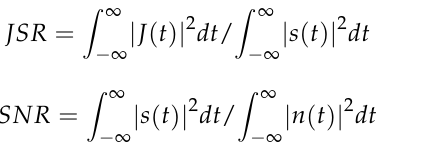
(cid:9) (cid:8) f q 2